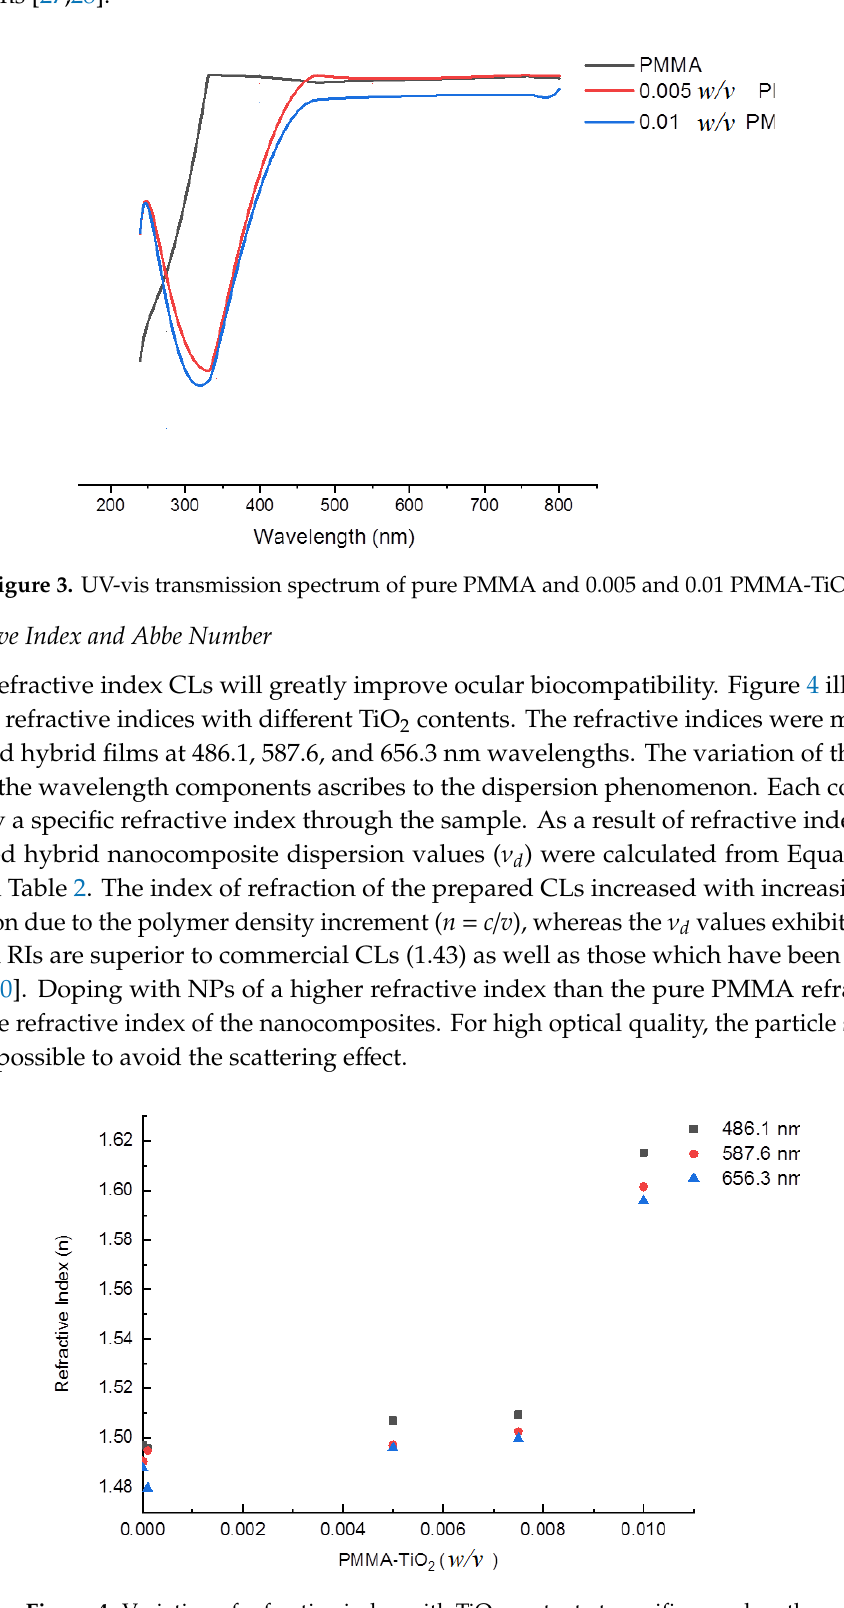
Figure 4. Variation of refractive index with TiO 2 content at specific